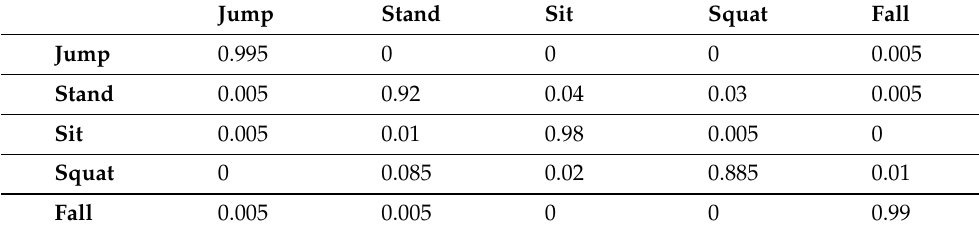
Table 3. Confusion matrix of